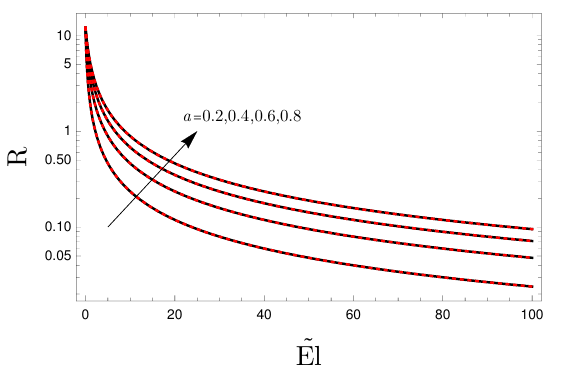
Figure 4. Comparison between asymptotic solution for k → 0 (red dashed curves) and the neutral stability condition obtained numerically for k = 10 − 3 (black solid curves); R versus